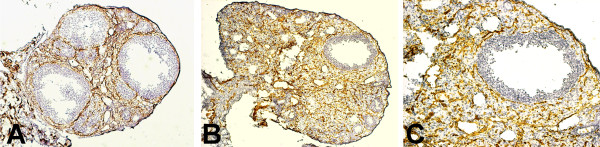
Inhibition of Notch signaling with a γ-secretase inhibitor (Compound E) blocked follicle development to the preovulatory stage. Immunohistochemistry for PECAM (brown) counterstained with hematoxylin. Please note disorganized appearance of PECAM staining in treatment group. A) three control preovulatory follicles (10× magnification) B) γ-secretase inhibitor treated follicles (10× magnification) C) Enlargement of treatment follicle in B (20 × magnification).